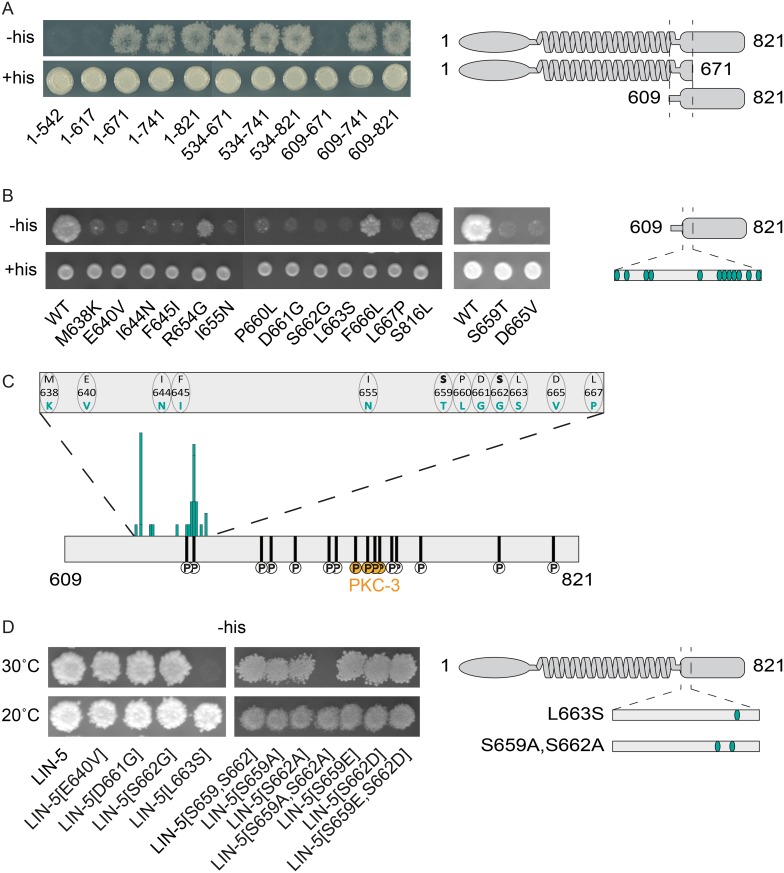
Yeast two-hybrid assays identify critical residues in LIN-5 for GPR-1 interaction.(A) Yeast two-hybrid analysis of DB::GPR-1 (bait) interaction with AD::LIN-5 (prey) fragments of varying sizes on Sc (synthetic complete) −Leu−Trp (+His, control) and Sc −Leu−Trp−His + 3-AT (-His, selection) plates. (B) Yeast two-hybrid analysis of DB::GPR-1 (bait) interaction with AD::LIN-5 (prey) fragments containing single amino acid changes on Sc −Leu−Trp and Sc −Leu−Trp−His + 3-AT plates. (C) Graphical representation of LIN-5 residues required for GPR-1 binding. Size of bars indicates frequency of found mutations, with every bar representing a different amino acid change. (D) Yeast two-hybrid analysis of DB::GPR-1 (bait) interaction with AD::LIN-5 (prey) full length containing single amino acid changes on Sc −Leu−Trp−His + 3-AT plates at 20°C and 30°C.